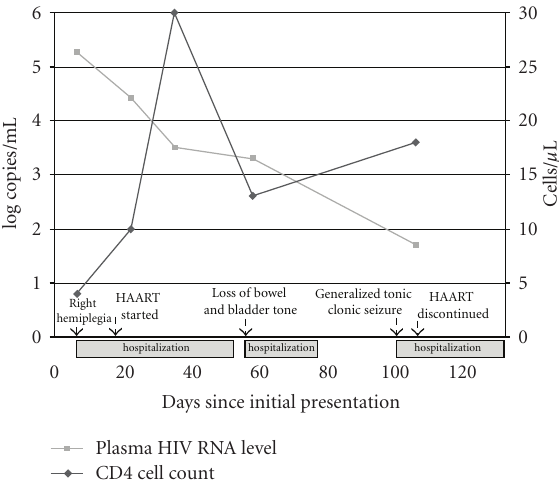
Figure 5: Clinical manifestations and plasma HIV RNA and CD4 cell count